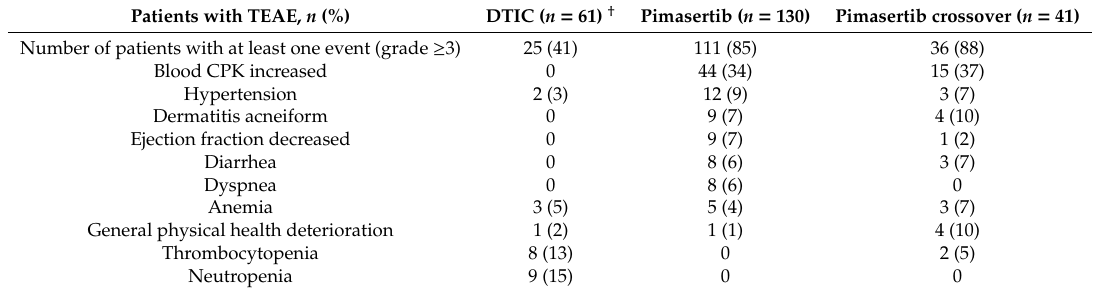
Table 3. Most common grade ≥ 3 TEAEs ( > 5% of patients in any treatment group) (safety analysis set) 1 . Patients with TEAE, n (%) DTIC ( n = 61) † Pimasertib ( n = 130) Pimasertib crossover ( n = 41) Number of patients with at least one event (grade ≥ 3) 25 (41) 111 (85) 36 (88) Blood CPK